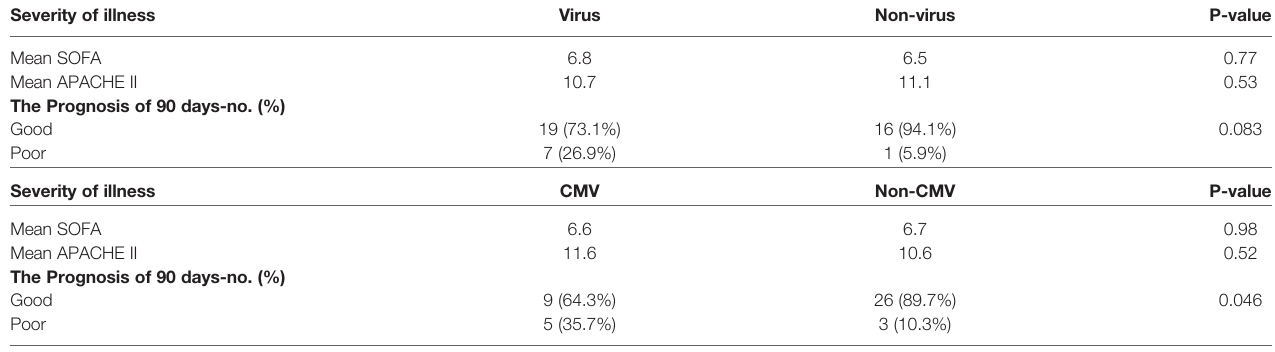
TABLE 2 | Demographic and Clinical Characteristics of study cohort.